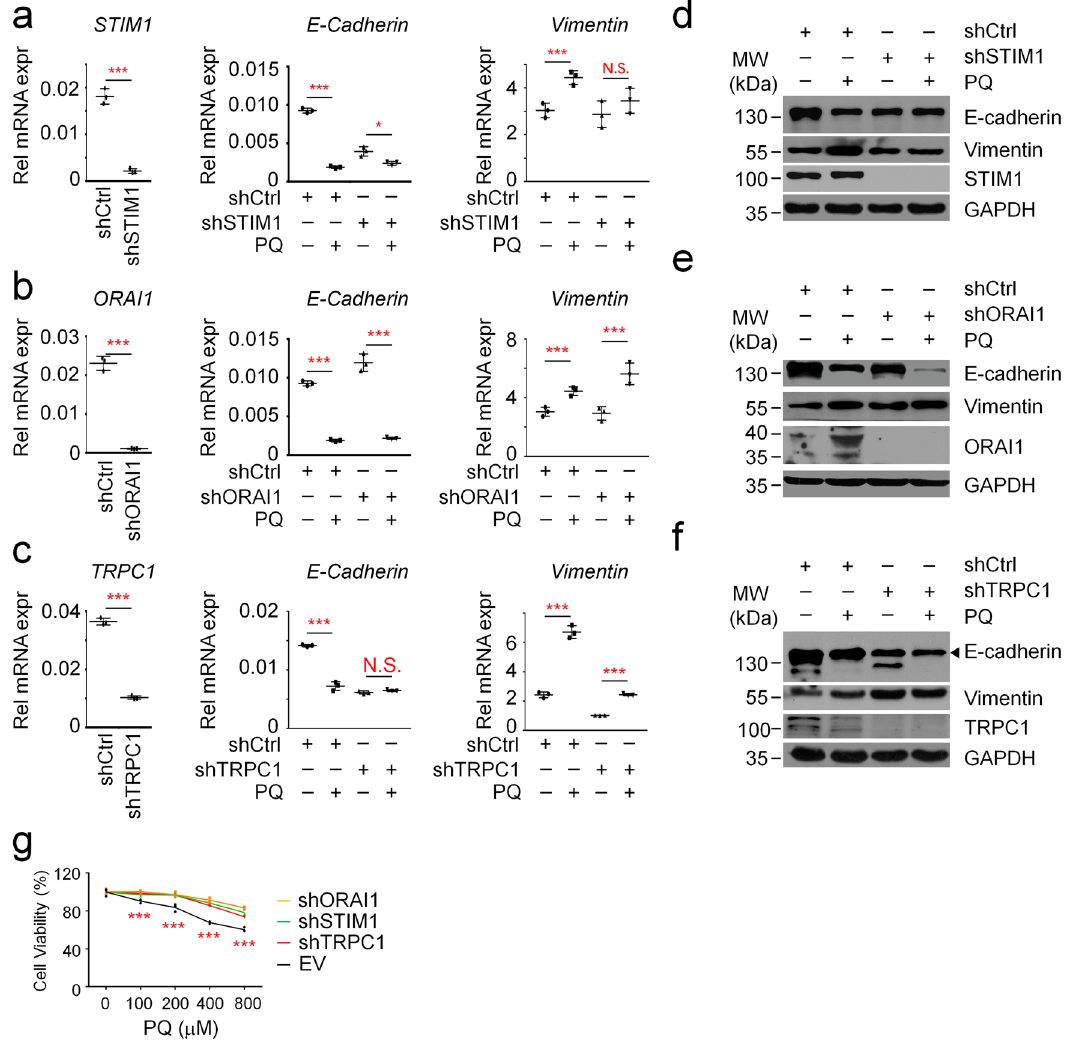
Fig. 5 PQ induces EMT and cell death mainly via the STIM1-TRPC1 axis. a – c RT-PCR analysis to detect the expression of STIM1, ORAI1, TRPC1, E-Cadherin, or Vimentin in A549 cells infected with shRNA-STIM1 ( a ), shRNA-ORAI1 ( b ), or shRNA-TRPC1 ( c ), respectively. The cells were treated w/wo 800 μ M PQ for 24hours. d – f WB analysis of the expression of E-Cadherin and Vimentin, makers of EMT, in A549 cells infected with shRNA-STIM1 ( d ), shRNA-ORAI1 ( e ), or shRNA-TRPC1 ( f ), respectively. The cells were treated w/wo 800 μ M PQ for 24hours. g SRB analysis of cell viabilityin A549 cells infected with shRNA-STIM1, shRNA-ORAI1, or shRNA-TRPC1. The cells were treated with 0, 100, 200, 400, or 800 μ M PQ for 24hours, as indicated. COMMUNICATIONS BIOLOGY| (2022) 5:1151